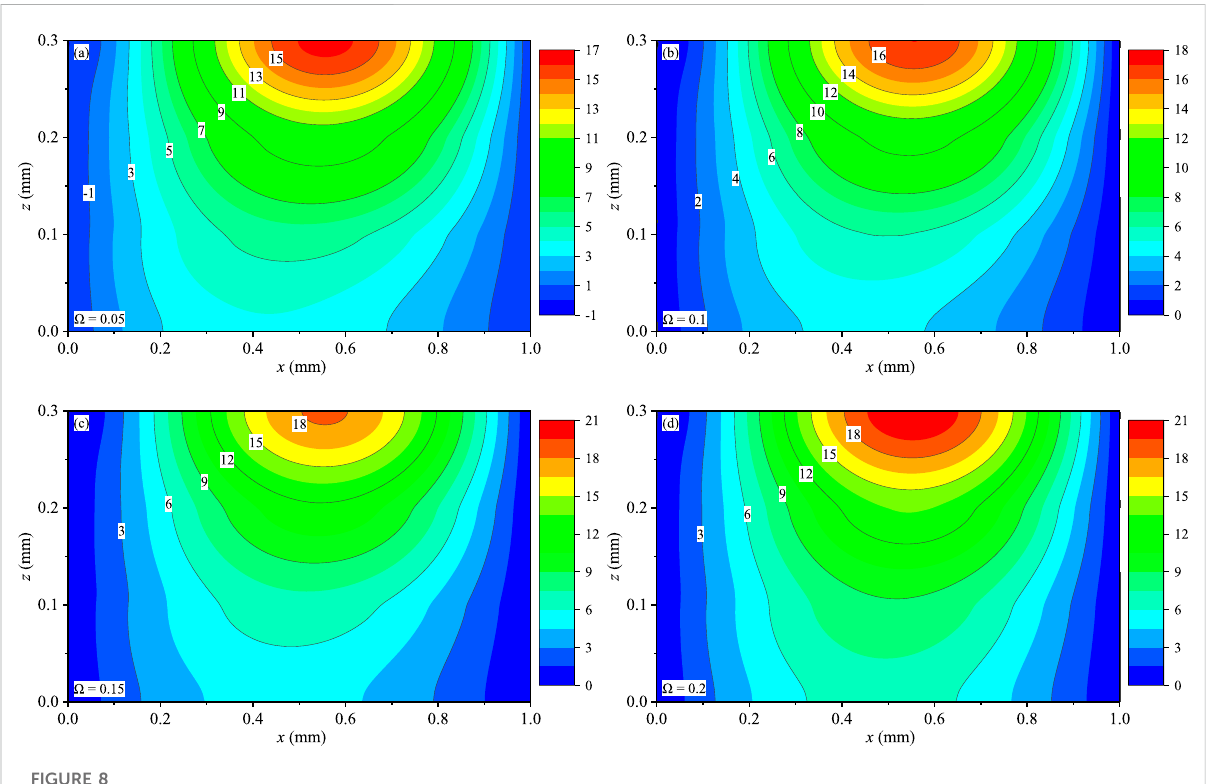
FIGURE 8 Effect of Ω on the phonon displacement w y (10 − 9 mm): (A) Ω = 0.05, (B) Ω = 0.1, (C) Ω = 0.15, and (D) Ω =